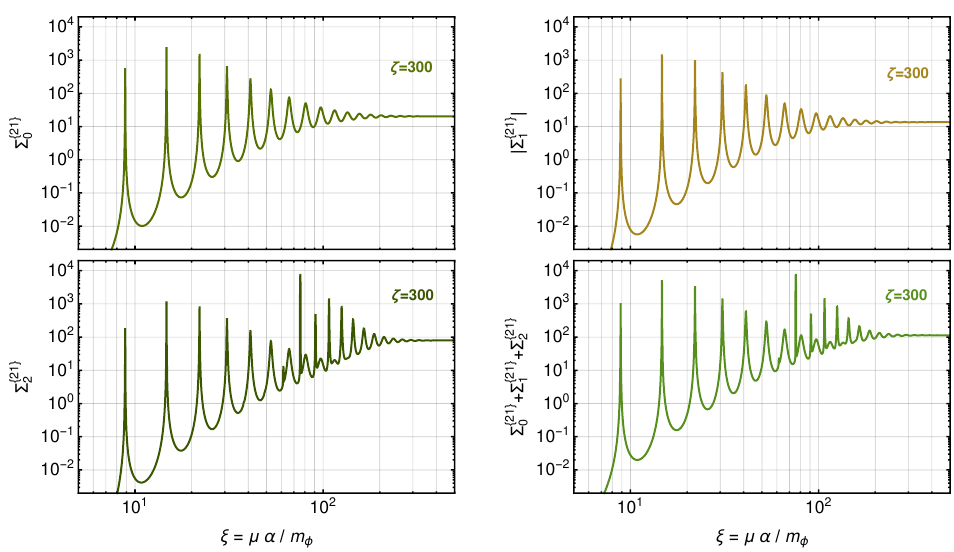
Figure 11 . The factors (cid:6) f 21 g ( (cid:16); (cid:24) ), (cid:6) f 21 g ( (cid:16); (cid:24) ) and (cid:6) f 21 g ( (cid:16); (cid:24) ) that contribute to the cross-section 0 1 2 for the radiative capture of a particle-antiparticle pair into any n = 2 ; ‘ = 1 state, with emission of a scalar force mediator [cf. eqs (4.12)]. The bottom right panel shows their sum, which corresponds to S f 21 g , provided that the phase-space suppression is negligible. (cid:6) f 21 g and (cid:6) f 21 g involve only the 0 1 BSF ‘ = 1 mode of the scattering state wavefunction, while (cid:6) f 21 g includes contributions both from the 2 ‘ = 1 and ‘ = 3 components. The latter is responsible for the sharper resonances at large (cid:24)